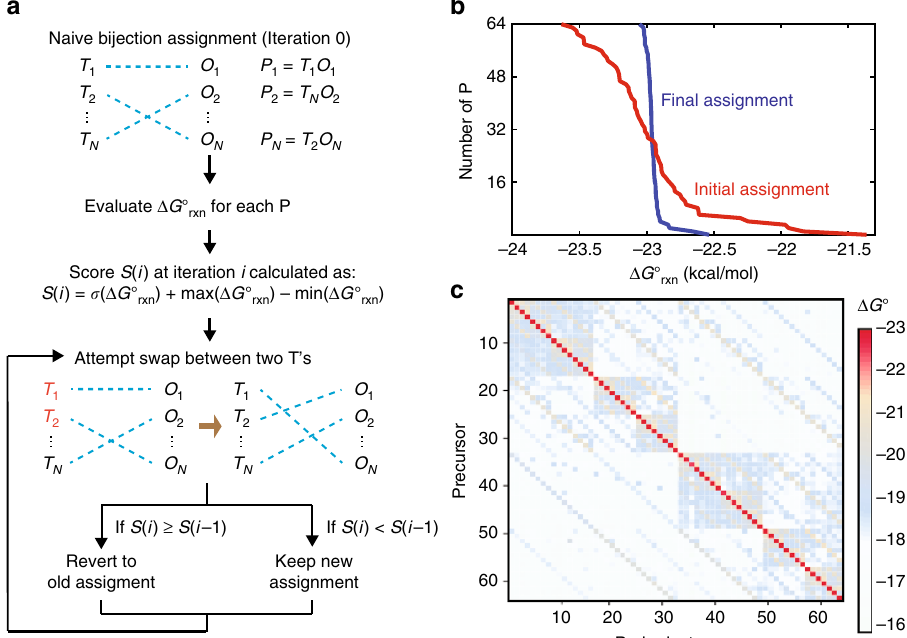
Fig. 3 Precursor sequence design. Similar stoichiometry of SNOP products requires both (1) similar concentrations of probe randomer instances and (2) similar standard free energies of reaction Δ G (cid:1) rxn